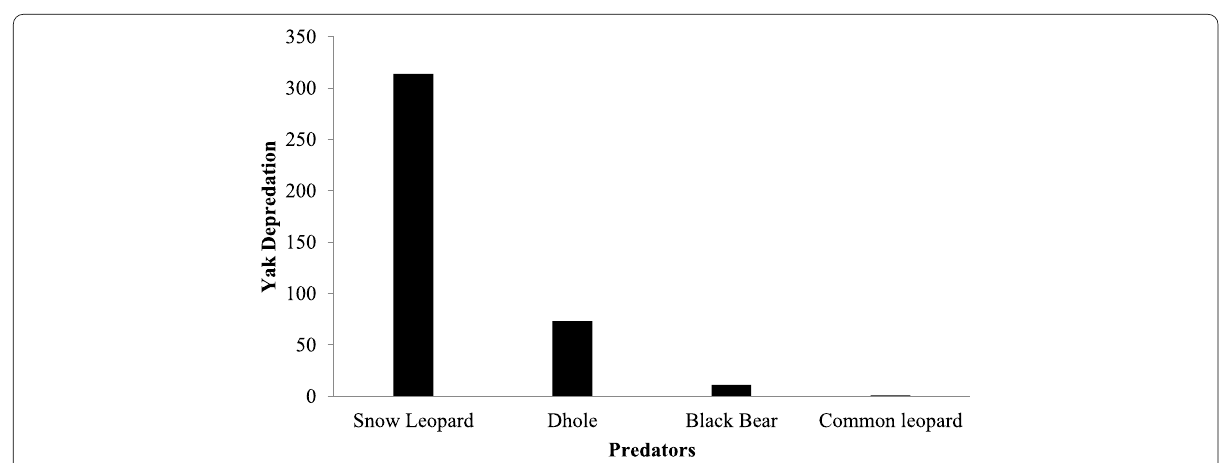
Fig. 3 Yak depredation composition by wild predators